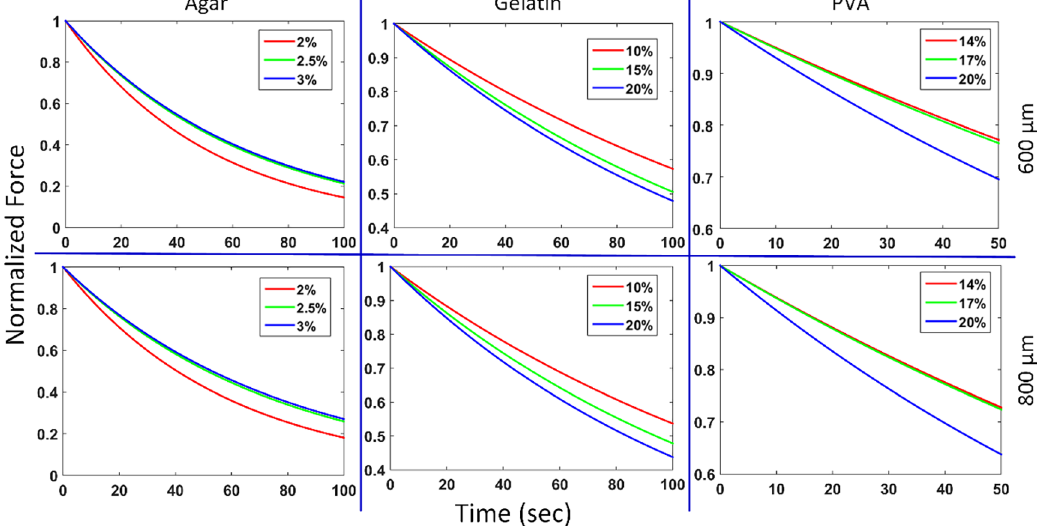
Fig 4. Mean elastic relaxation behavior plots of agar, gelatin, and PVA TMPs as a function of time. The top and bottom rows illustrate the 600 μm and 800 μm indentation behaviors, respectively. As shown, gelatin and PVA have the same relaxation behavior, but the opposite is observed for agar